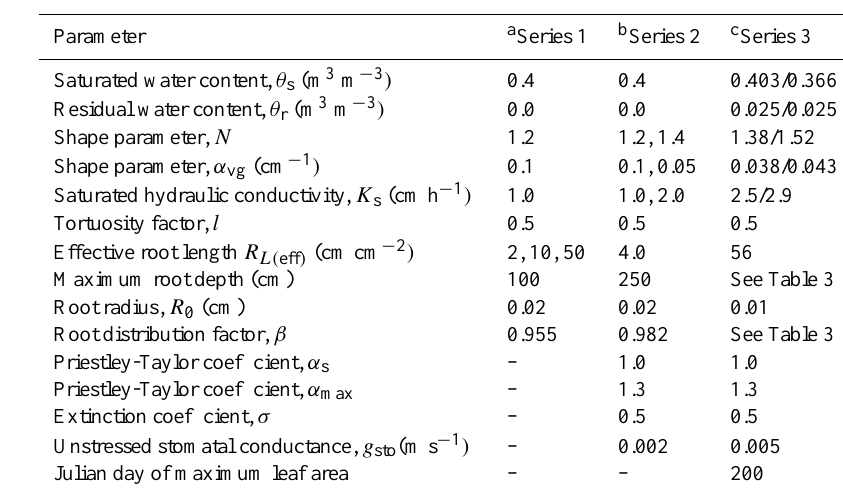
Table 1. Parameter values used in the